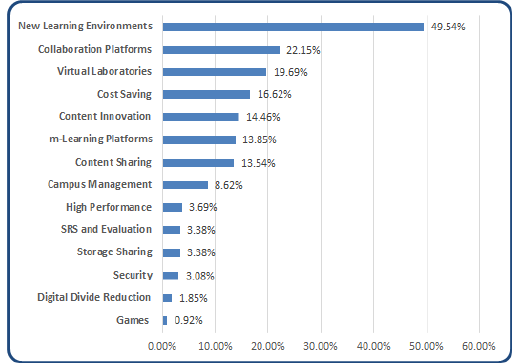
Figure 3. Results of RQ1: topics covered in the papers.